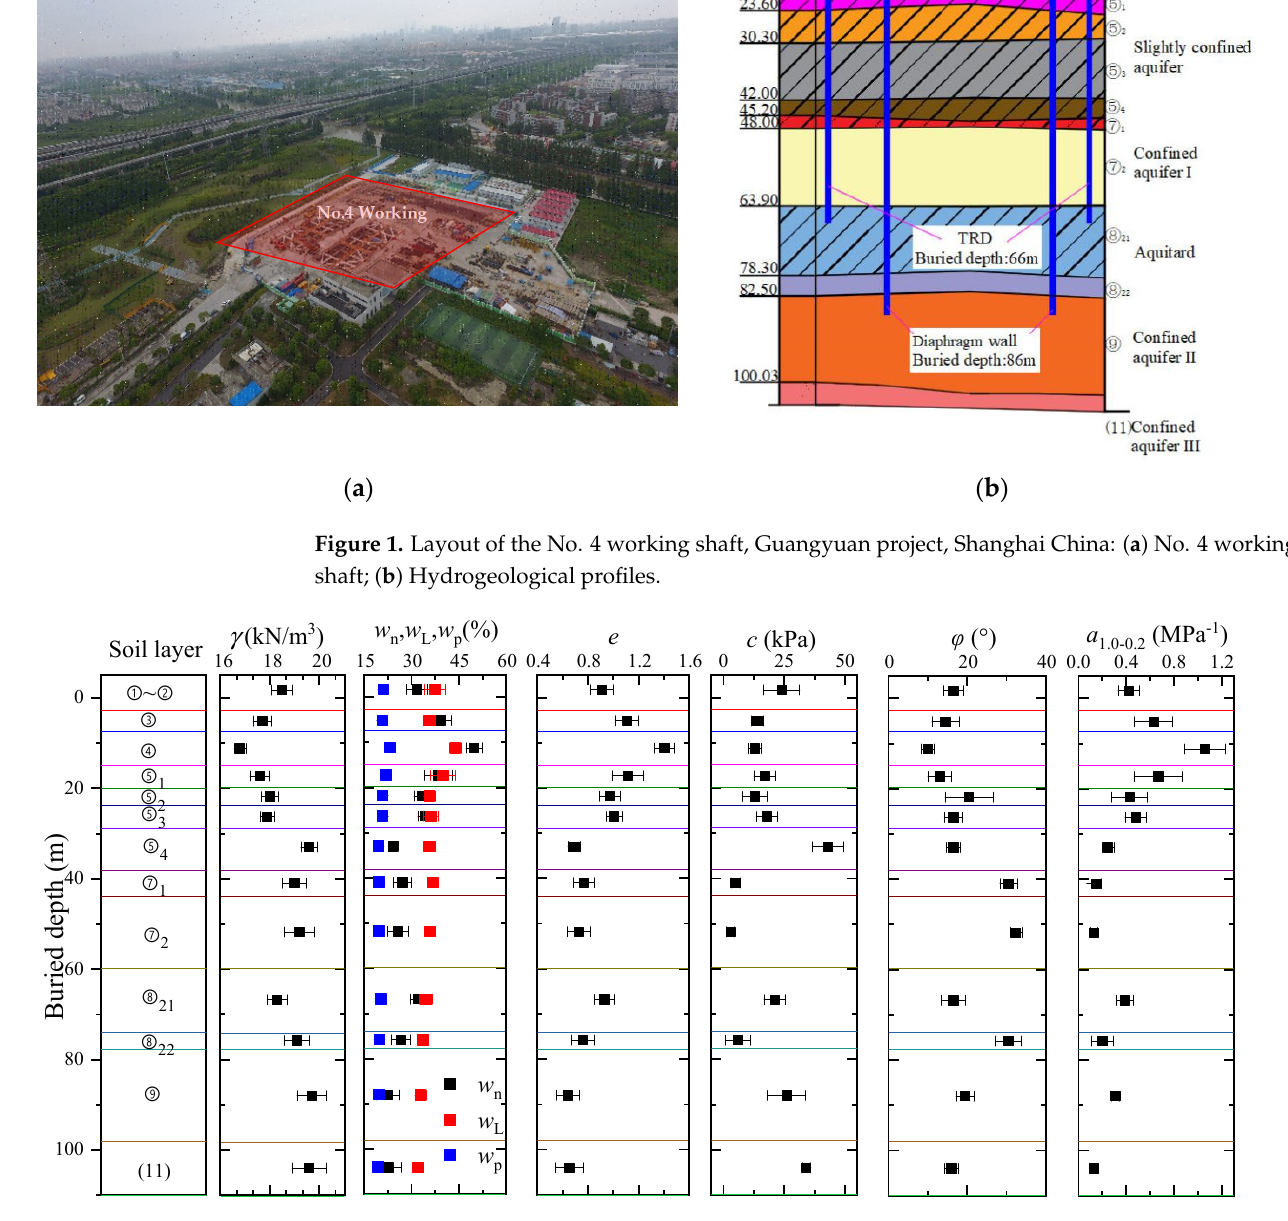
Figure 2. Soil parameters of the No. 4 working shaft, Guangyuan project, Shanghai China. Note: γ = unit weight; w n = water content; w p = plastic limit; w L = liquid limit; e = void ratio; 1.0 0.2 － = coeffient of compressibility; c = cohesion; φ = internal friction angle.